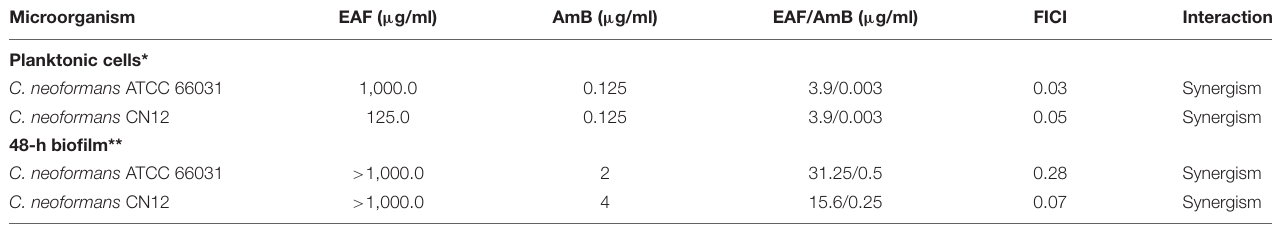
TABLE 2 | Effect of ethyl acetate fraction (EAF) combined with amphotericin B (AmB) against planktonic cells and mature biofilm of Cryptococcus neoformans. Microorganism EAF ( µ g/ml) AmB ( µ g/ml)